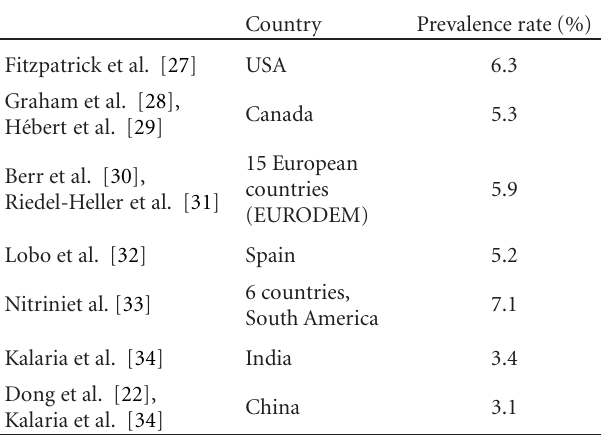
Table 2: Prevalence of dementia (clinical criteria) in people aged > 65